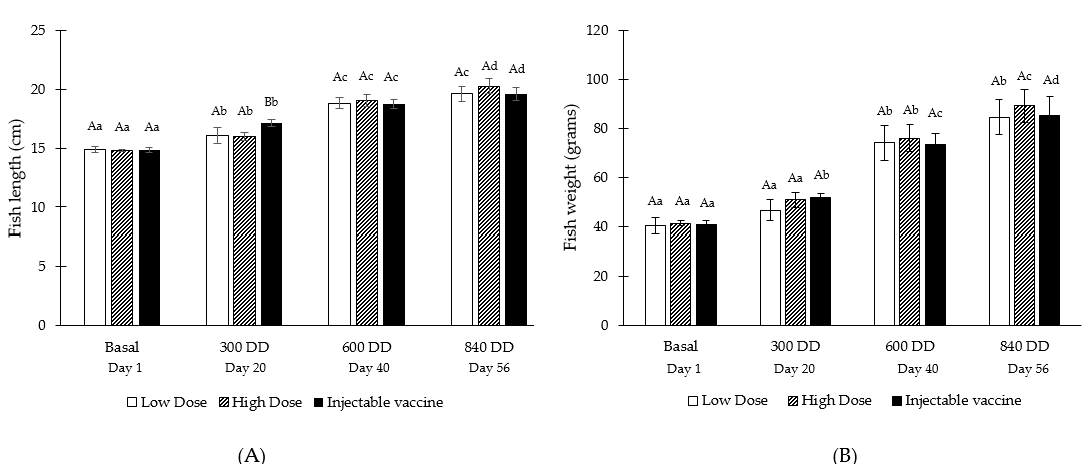
Figure 4. Fish length ( A ) and weight ( B ) of Atlantic salmon ( Salmo salar) fed with experimental diets at different sampling points during the trial. Different capital letters indicate significant differences ( p ≤ 0.05) of the length or weight among the different experimental groups (low dose, high dose, injectable vaccine) within the same sampling point. Different lowercase letters indicate significant differences ( p ≤ 0.05) of the length or weight among the different sampling points (baseline, 300, 600 and 840 DD) within the same experimental group.